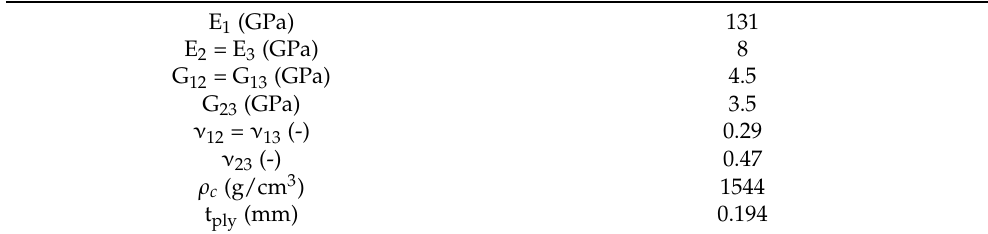
Table 3. The mechanical properties of the USN150B carbon fiber-reinforced polymer (CFRP) material